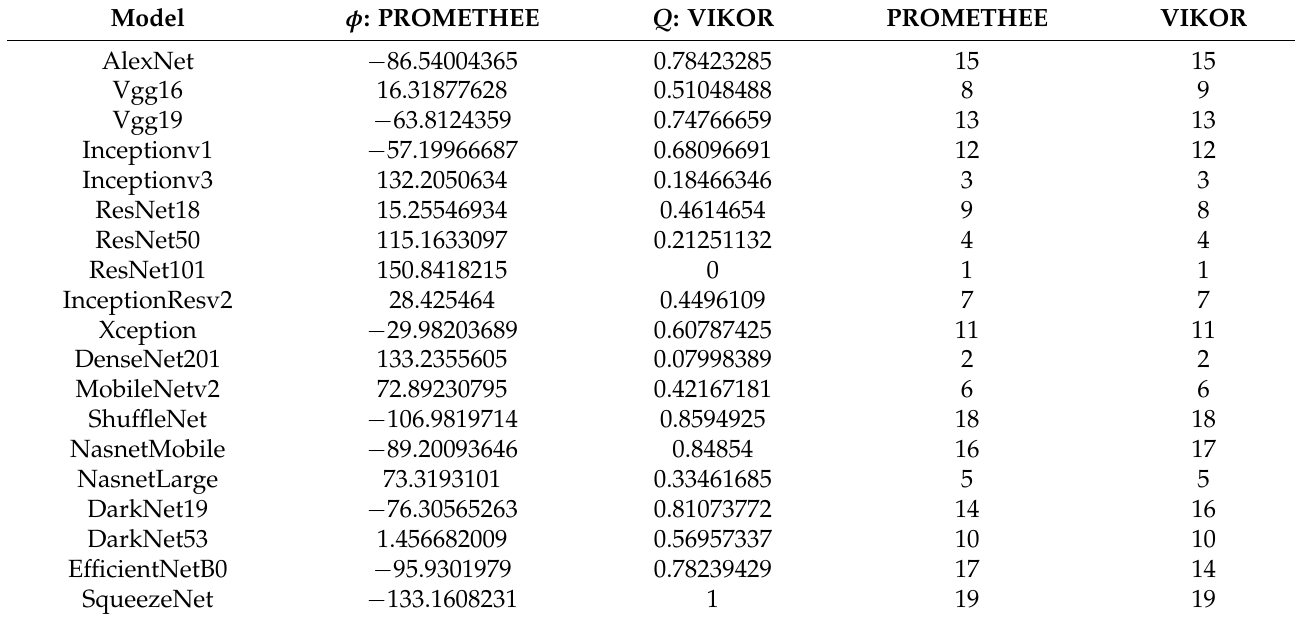
Table 5. Ranking for decision making represented by the values of φ in PROMETHEE and Q in VIKOR. The highest φ value is the best, whereas the lowest Q is the best.